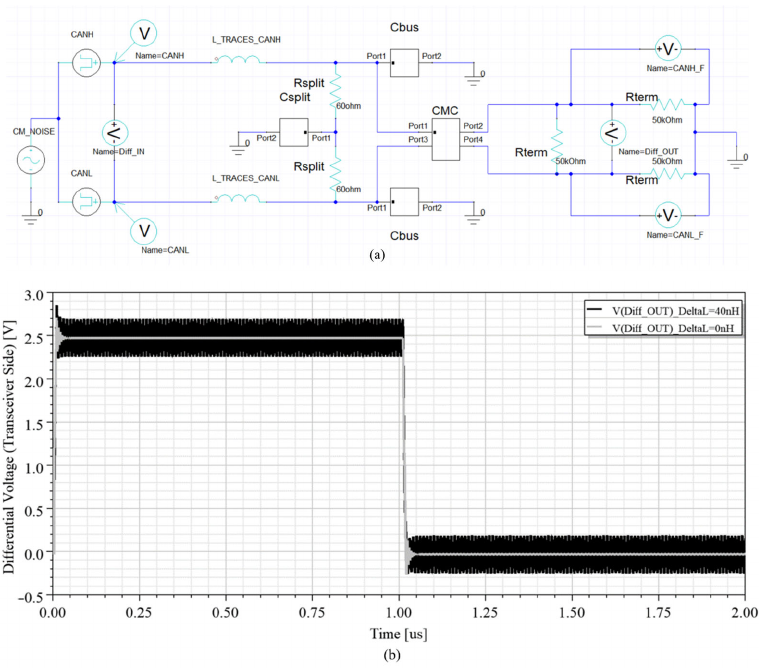
Figure 12. Simulated circuit ( a ) and transient results ( b ) of the CAN bus asymmetries introduced by PCB traces: comparison between Δ L = 0 nH and Δ L = 40 nH is shown.